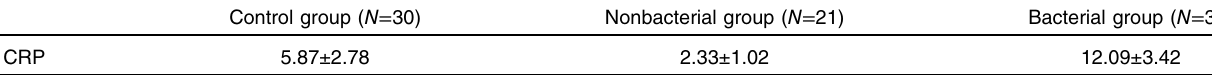
Table 16 Comparison between mean values of CRP in the studied groups Control group ( N = 30) Nonbacterial group ( N = 21) CRP